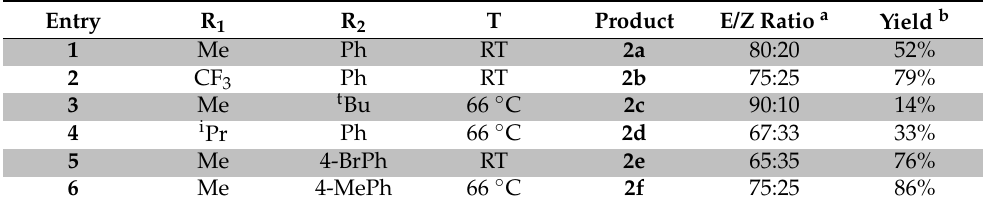
Table 1. Synthesis of acrylate intermediates 2a – f .